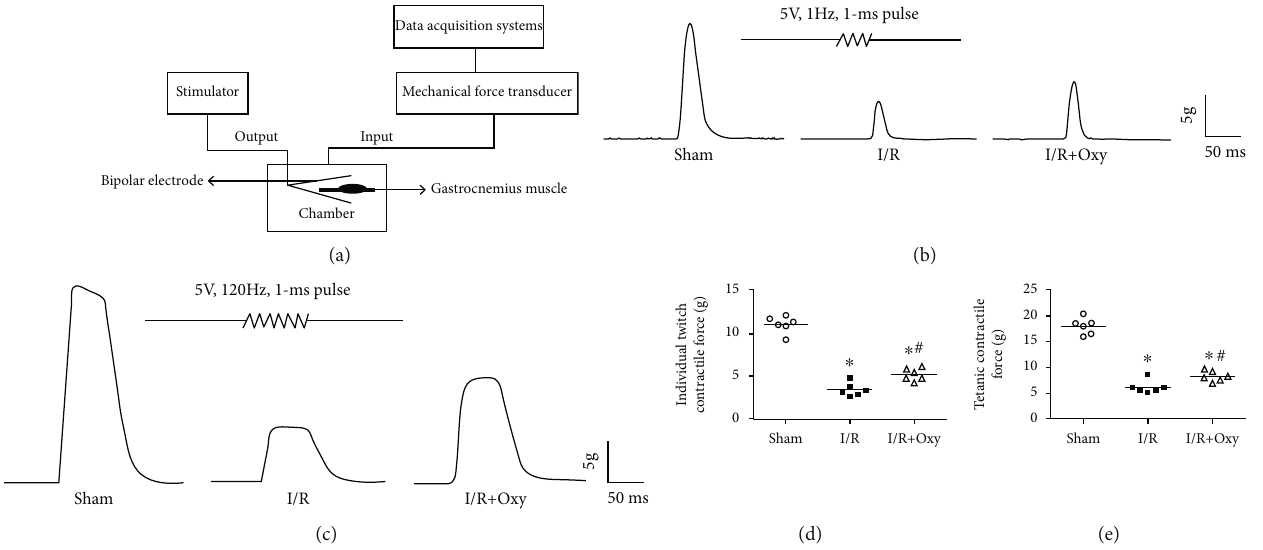
Figure 5: Oxy attenuated impairment of contractility of gastrocnemius muscles induced by a tourniquet. (a) Schematic diagram of experimental setup. (b) Individual twitch contraction of the gastrocnemius muscle. (c) Tetanic contractile force. (d, e) Quantitative analysis of individual twitch contractile force and tetanic contractile force in di ff erent groups. I/R: ischemia-reperfusion; Oxy: oxycodone. Data are expressed as the mean ± SE ( n = 6 in each group); ∗ P < 0 : 05 vs. sham; # P < 0 : 05 vs.